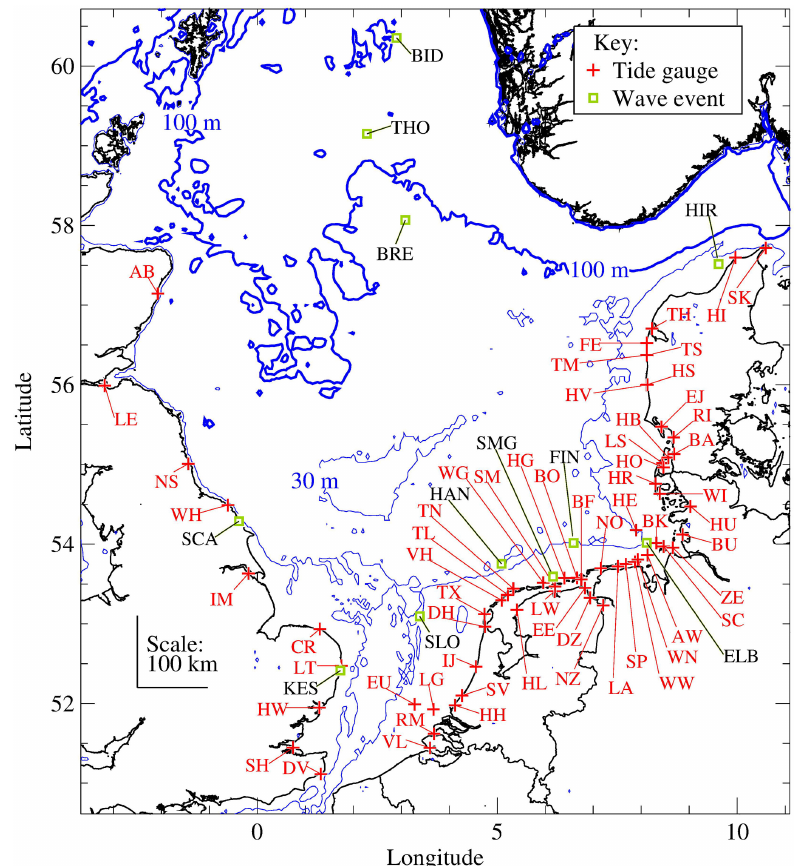
Figure 1. Map of tide gauge stations and large wave events during Storm Britta on 31 October–1 November 2006. The wave events in- clude media reports of wave strikes that have damaged ships, interrupted platform operations, or caused shoreline incidents, in addition to recordings of automated instrumentation. Information on the tide gauges and large wave events are given in the